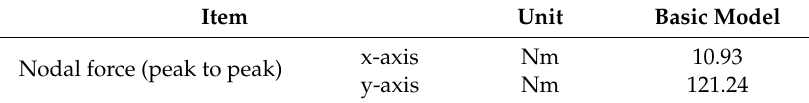
Figure 6. Nodal force of the stator teeth (absolute component). Table 3. Nodal force component in x-axis and y-axis